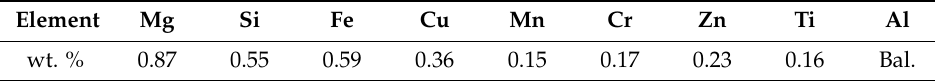
Table 1. Chemical composition of AA 6061 alloy (in